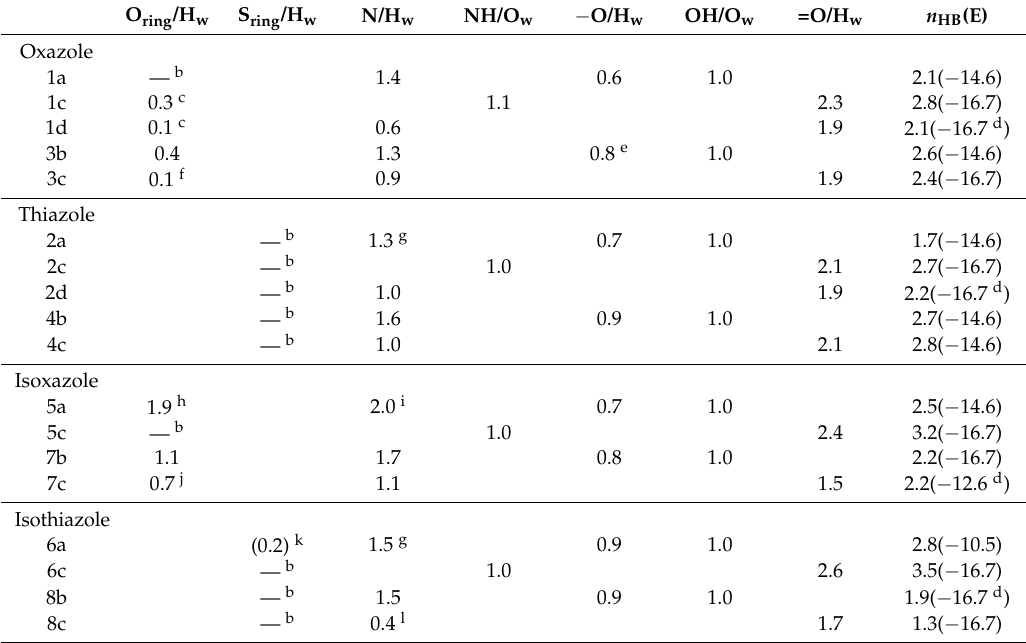
Table 5. Coordination numbers (CN) and numbers of solute ´ water hydrogen bonds a